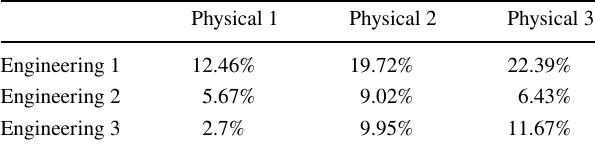
Table 4 Proportion of sweet spot combination in B2